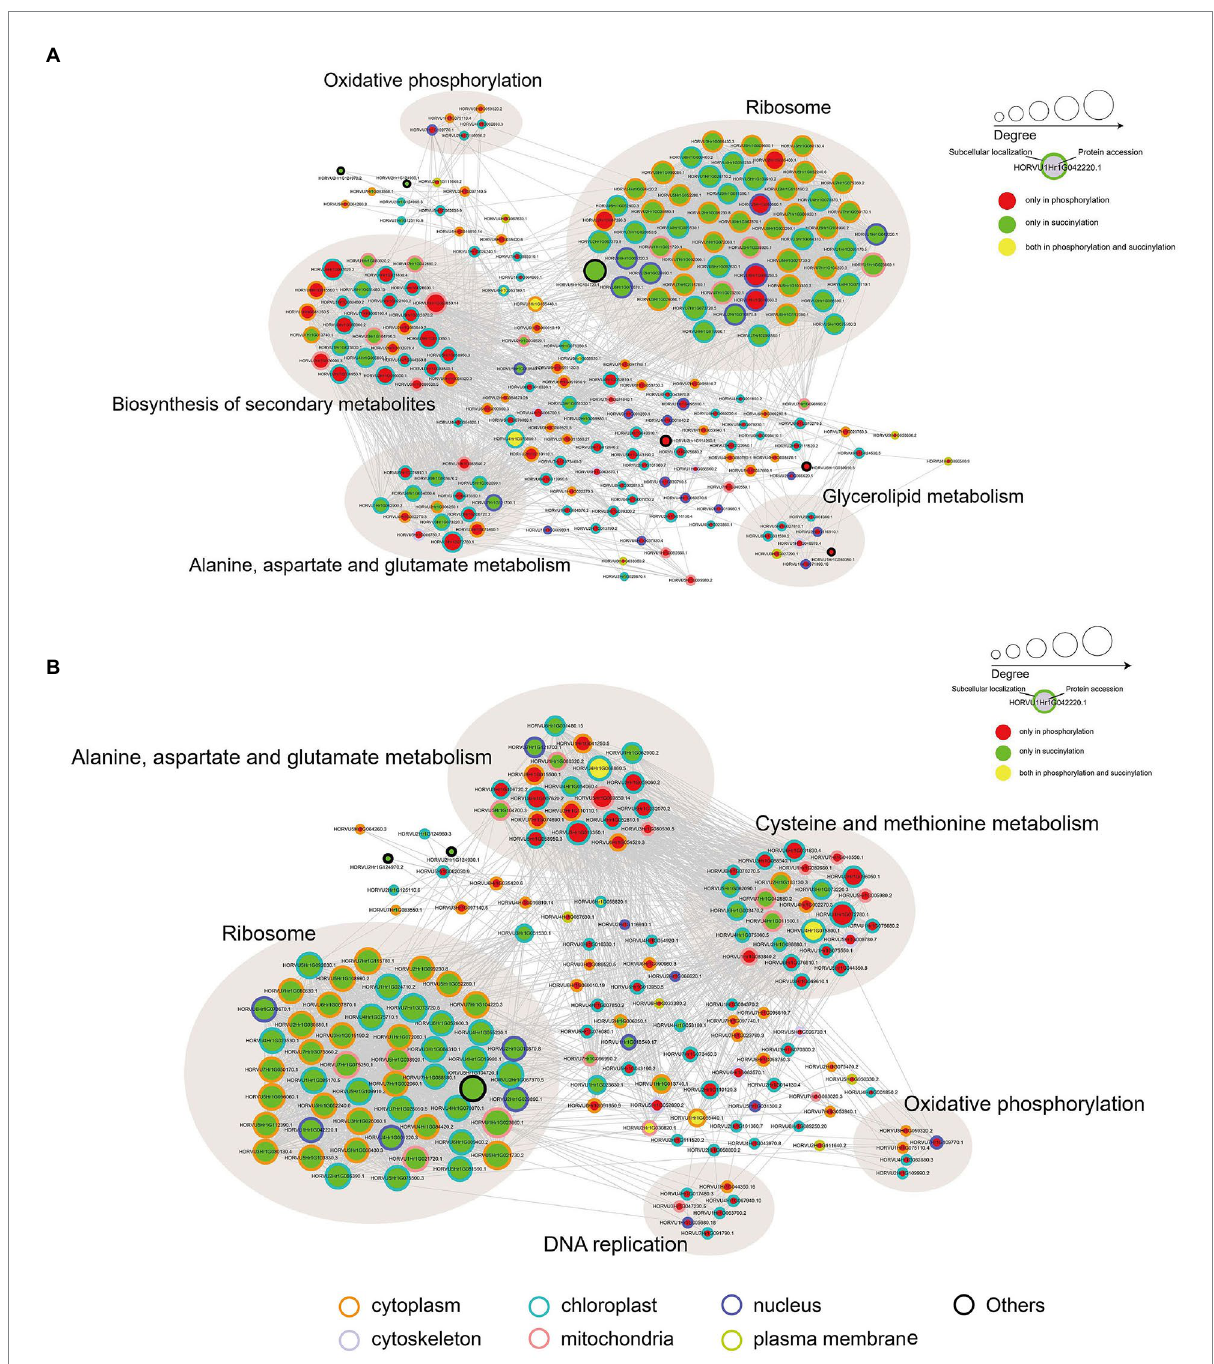
FIGURE 7 Protein–protein interaction (PPI) network analysis of significantly phosphorylated or succinylated, and both phosphorylated and succinylated proteins in response to Pi starvation (A) and recovery (B) , respectively. Phosphorylated and succinylated proteins belonging to the significantly enriched KEGG pathway in Pi starvation and Pi recovery stages were used for PPI analysis, respectively. PPI network were obtained from STRING software (v.11.0) and visualized by Cytoscape (3.7.2) after applying a confidence score of 0.4. Light brown circles depict clusters of proteins involved in specific metabolic pathways. The circle size represents the number of interaction nodes; the greater the number of interaction nodes, the larger the circle. Node outlines indicate the predicted subcellular localization of proteins. Cytoplasm (orange), cytoskeleton (lavender), mitochondria (pink), nucleus (purple), plasma membrane (green), chloroplast (blue), and others (black). Further details are in Supplementary Tables S16, S17. KEGG, Kyoto Encyclopedia of Genes and Genomes; Pi, intracellular phosphate; PPI, protein–protein